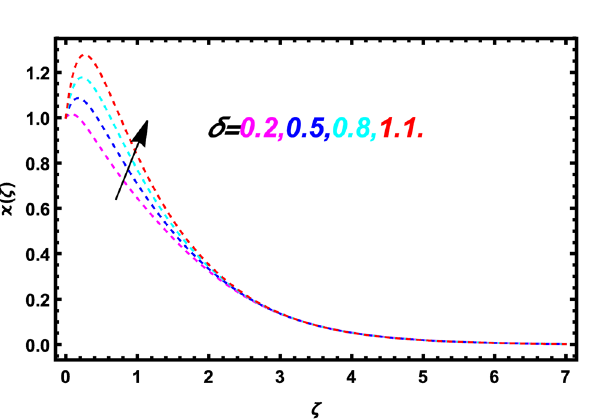
Figure 22. Demonstration of energy curve versus ε c when Fr = 0.2, k 1 = 0.1, k 2 = 0.3, M = 0.5, m = 0.2, Pr = 5.3, φ = 0.01, Ec = 0.3, ε t = 3.0, Rd = 0.2, Sc = 0.1, δ = 0.3, Lb = 0.3, Pe = 0.3.